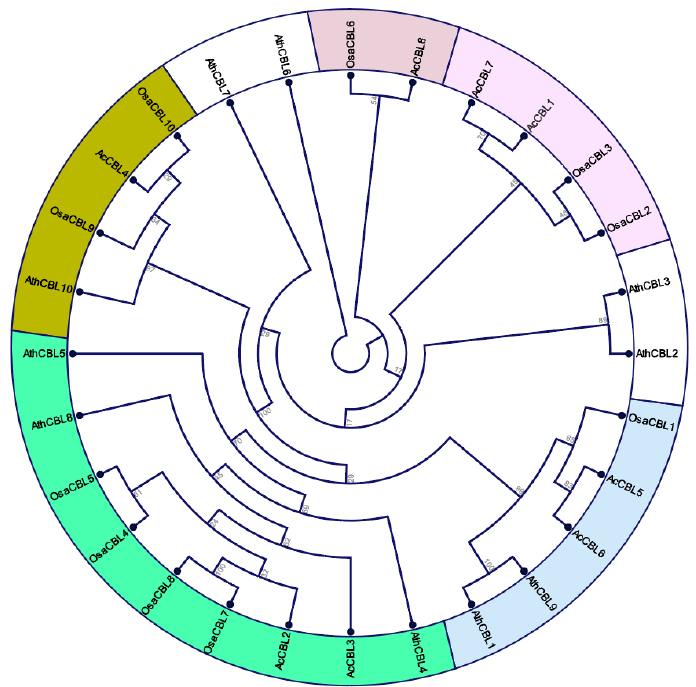
Figure 2. Phylogenetic tree depicting the relationships among CBL proteins from pineapple, rice, and Arabidopsis . The different colored arcs indicate different subgroups. Prefix ‘Ath’, Osa, and ‘Ac’ indicate CBL proteins from Arabidopsis , Oryza sativa, and Ananas comosus respectively.